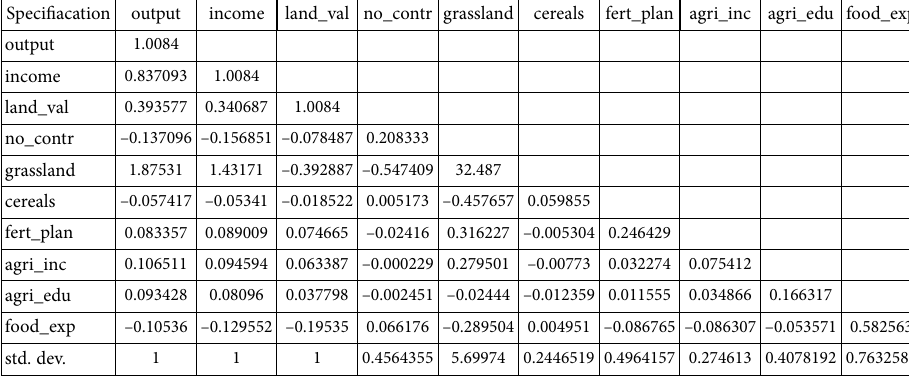
Table A.1. Covariances matrix of analysed